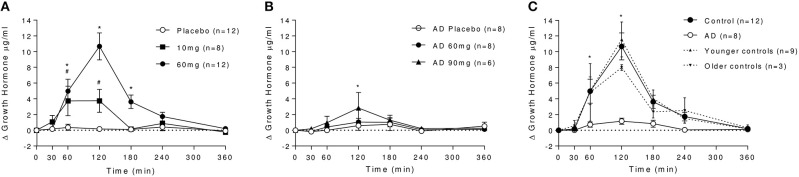
Effect of baclofen on plasma GH levels in controls and AD. Data are mean ± S.E.M. (A) Effect of placebo, 10 and 60 mg baclofen on GH levels in controls. A significant effect of time, dose and a dose by time interaction was observed [n = 8, Time: F(6, 48) = 10.44, P < 0.0001, Dose: F(2, 16) = 11.34, P = 0.0009, Dose × Time: F(12, 96) = 10.16, P < 0.0001]. *60 mg > placebo, #10 mg > placebo (P < 0.05, Tukey's multiple comparison test). (B) Effect of placebo, 60 and 90 mg baclofen on GH levels in AD. *90 mg > placebo (P < 0.05, Tukey's multiple comparison test). (C) Differential effect of baclofen on plasma GH levels in controls and AD. A significant effect of group [F(1, 18) = 15.36, P = 0.001], time [F(6, 108) = 16.35, P > 0.0001] and a dose × time interaction [F(6, 108) = 10.31, P < 0.0001] were observed. *Control > AD (P < 0.05, Sidak's multiple comparison test). Differential effects on GH in younger controls (cohort 1, n = 9, dashed line) and older controls (cohort 2, n = 3, dotted line) are also depicted in (C). There was no significant difference between GH levels following baclofen in younger and older control cohorts at any time point, and the significant differences between AD and both young and old controls remained (mixed ANOVA with Sidak's multiple comparison test). The average age of the younger cohort was 24.7 ± 4.7 years, compared with the older cohort (average age 52.0 ± 6.1) and the AD group (53.1 ± 8.9 years).